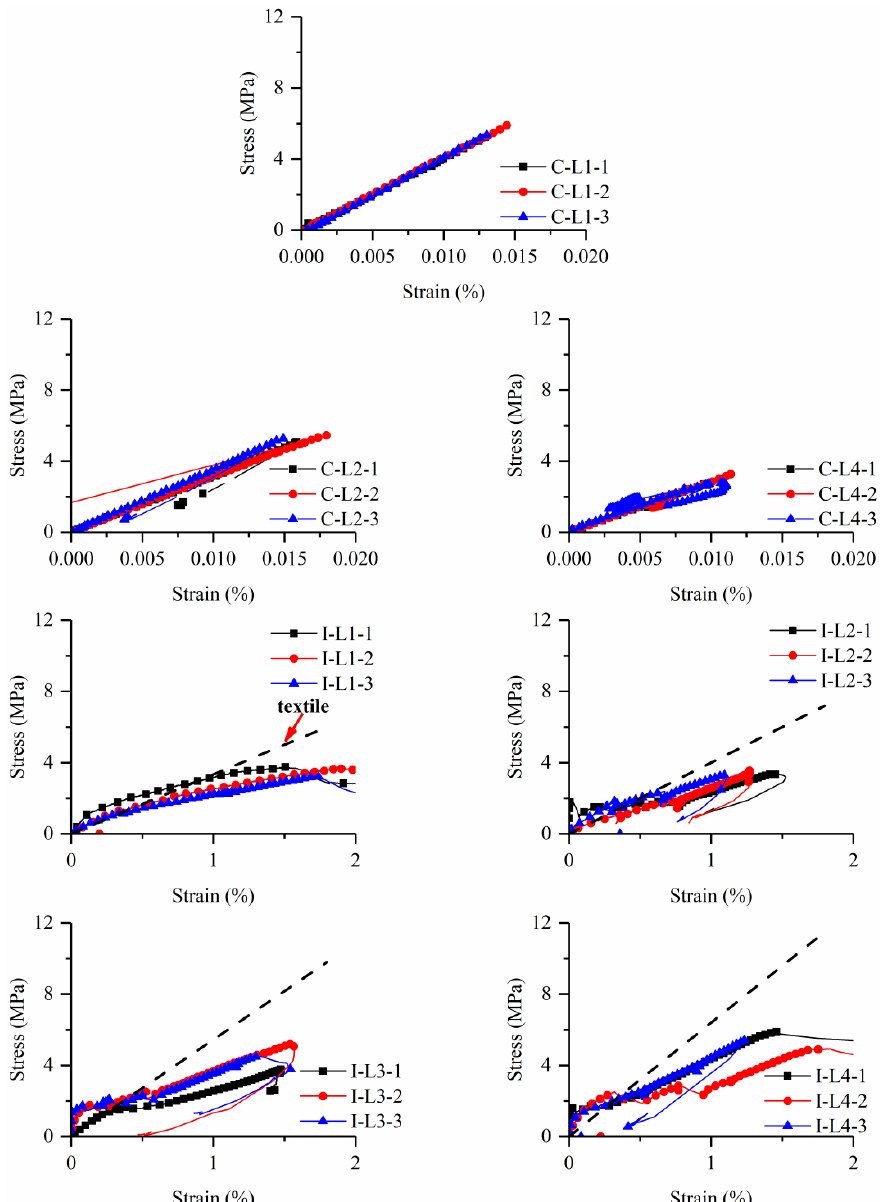
Figure 6. Tensile stress-strain curves of BTRC specimens.